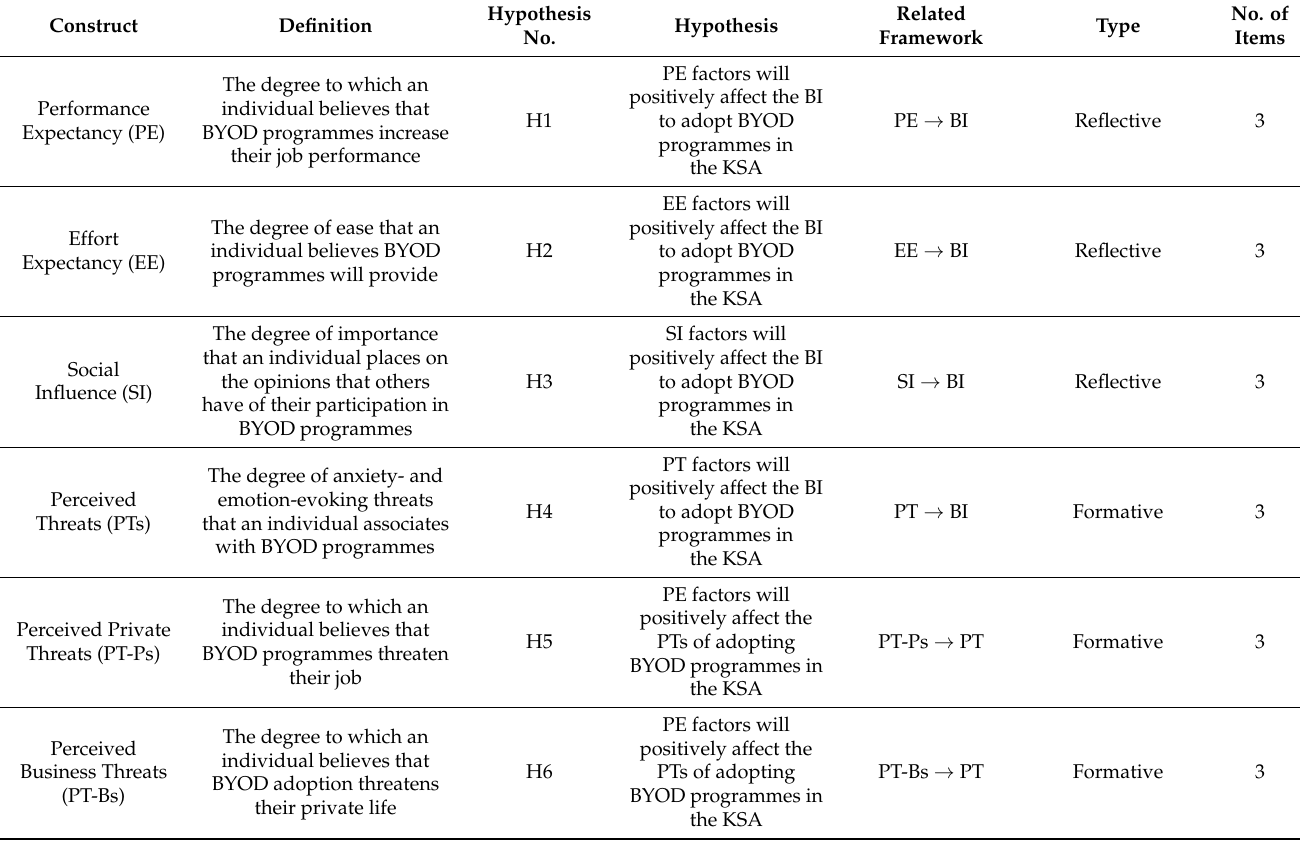
Table 1. Hypotheses and